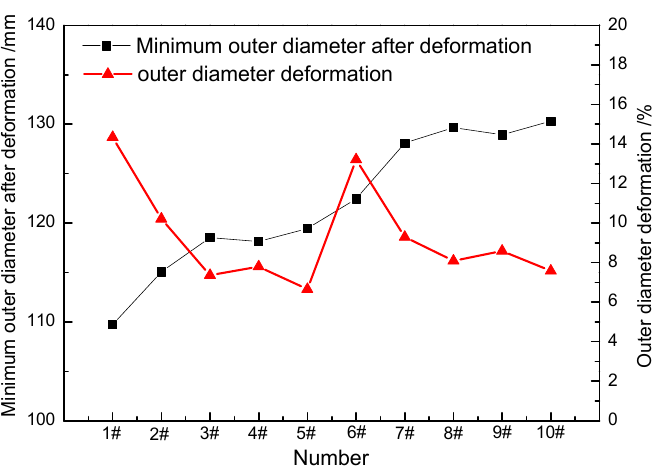
Figure 18. The casing minimum outer diameter and deformation value with modified cement sheath after extrusion.